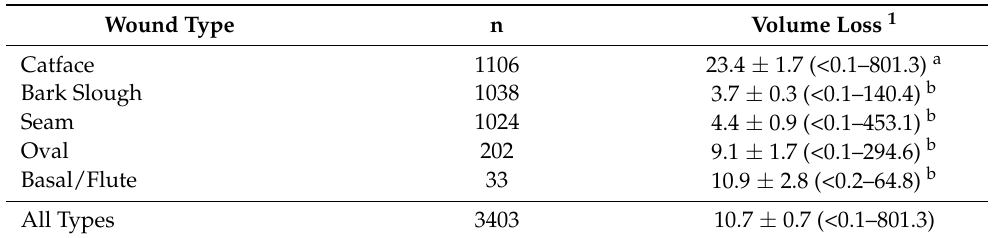
Table 3. Number of wounds (n) and volume loss (mean ± standard error) in dm 3 by wound